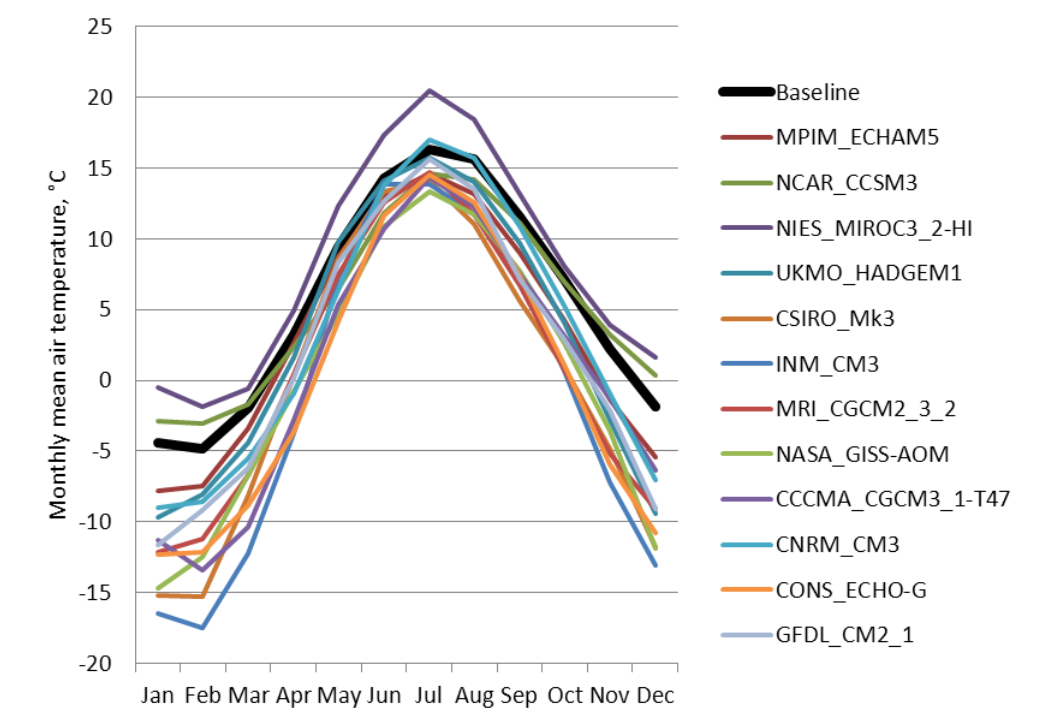
Fig. 2. Observed monthly mean temperatures (baseline) and the modelled values in western Estonia using 12 selected GCM outputs from AR4 during the control period 1961(cid:150)1990.